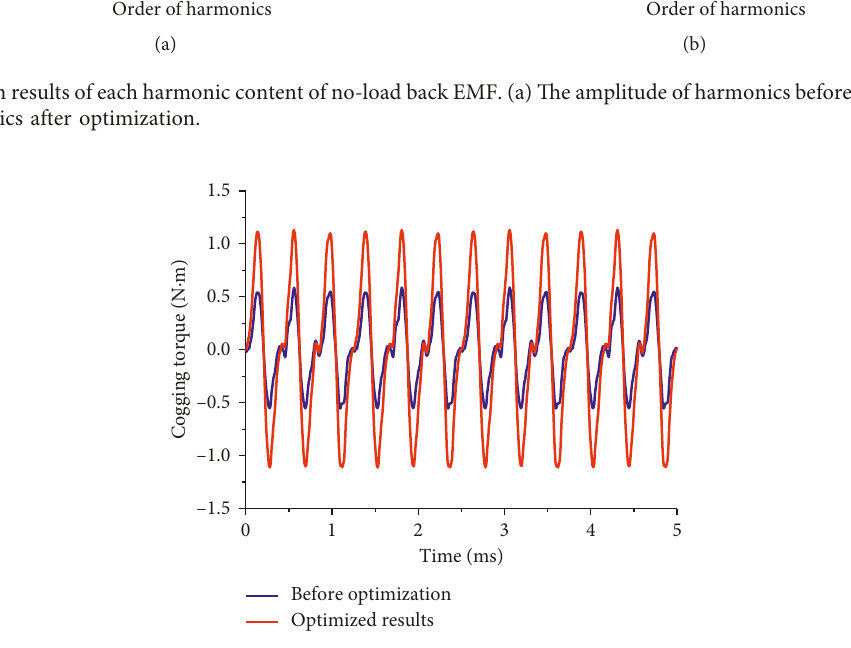
Figure 9: Comparison results of cogging torque.